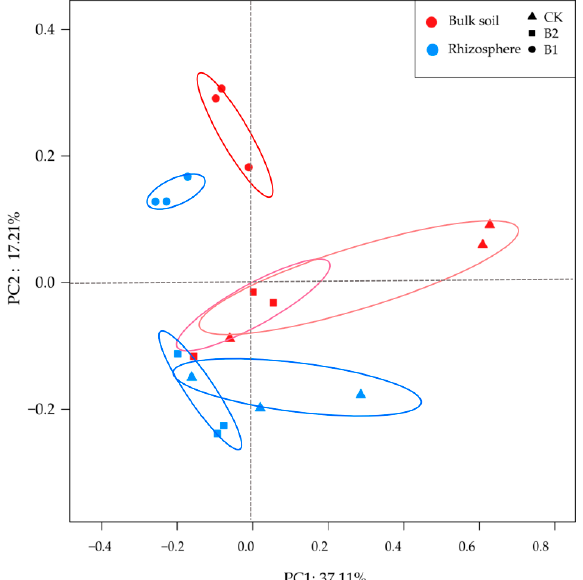
Figure 5. Principal coordinate analysis (PCoA) plot based on Bray–Curtis’s distance matrices showing the differences in bacterial community composition between rhizosphere and bulk soils of maize under biochar application (V9 stage). Treatment abbreviations (CK, B1, and B2) are defined in Figure 2 caption.